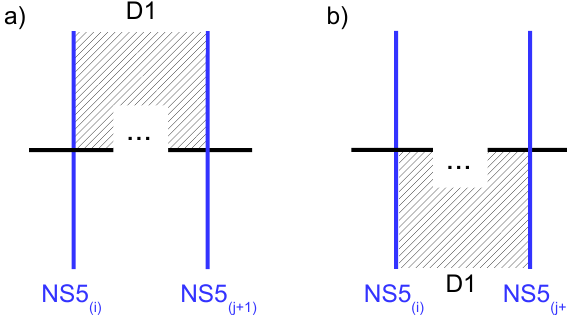
Figure 40 . Setups with D1 strings inserting scalar CB operators. The insertions are: a) ’ i (cid:0) ’ i (cid:0) 1 , b) ’ i (cid:0) 1 (cid:0) ’ i , c) ’ i (cid:0) ’ i (cid:0) 1 , d) ’ i (cid:0) 1 (cid:0) ’ i , e) m (cid:11) (cid:0) ’ i .